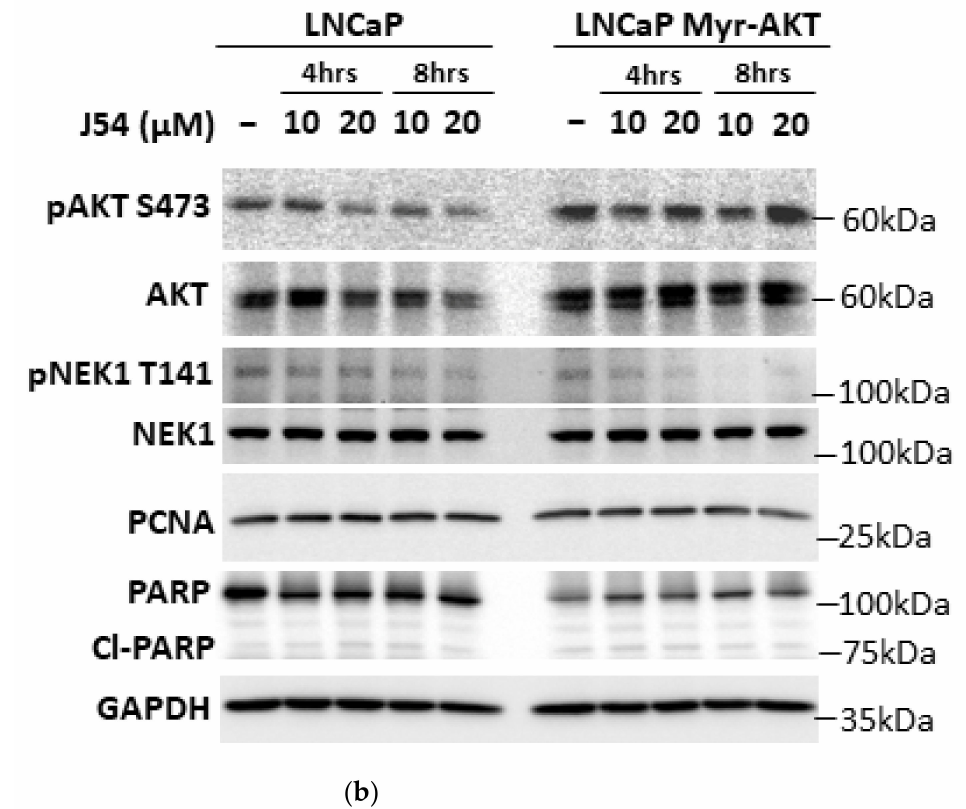
Figure 4. TLK1 regulation of cell proliferation is mediated through AKT activation as well as other pathways. ( a ) Proliferation rates of LNCaP and Myr-AKT expressing LNCaP cells with or without two different concentrations of the TLK1 inhibitor J54 treatment. The growth curves with standard error of mean (SEM) were obtained by plotting confluence percentage over time using IncuCyte. ( b ) Cell lysates were prepared from LNCaP and Myr-AKT expressing LNCaP cells treated with two different concentrations of J54 for two different time points. WB was conducted to determine the level of pAKT S473, total AKT, pNEK1 T141, total NEK1, PCNA, PARP, and cleaved PARP. GAPDH was used as a loading